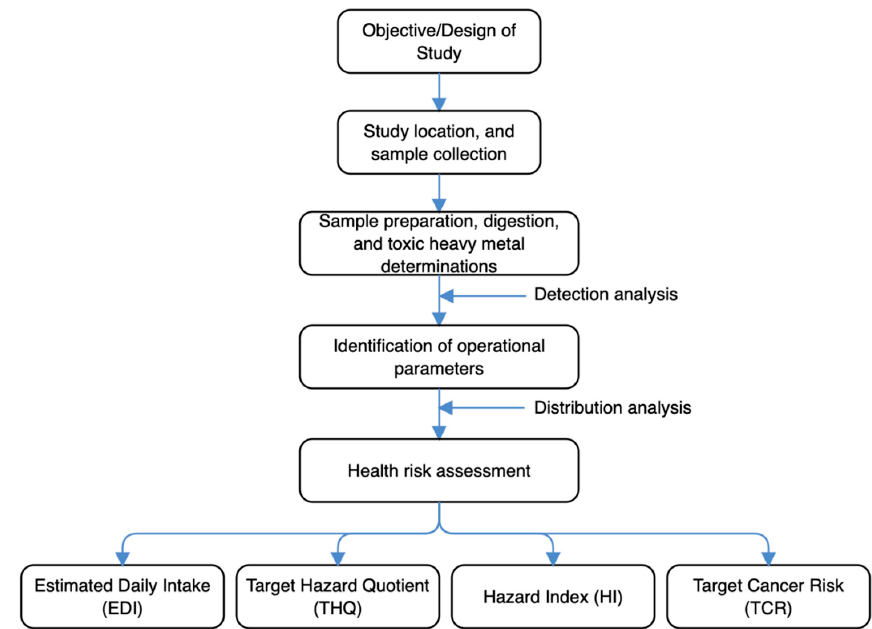
Figure 2. The schematic overview of the experimental program, from design of study, study location and sample collec- tion, its preparation, digestion, and toxic heavy metals/metalloids (THMs) determinations, identification of operational parameters, to the health risk